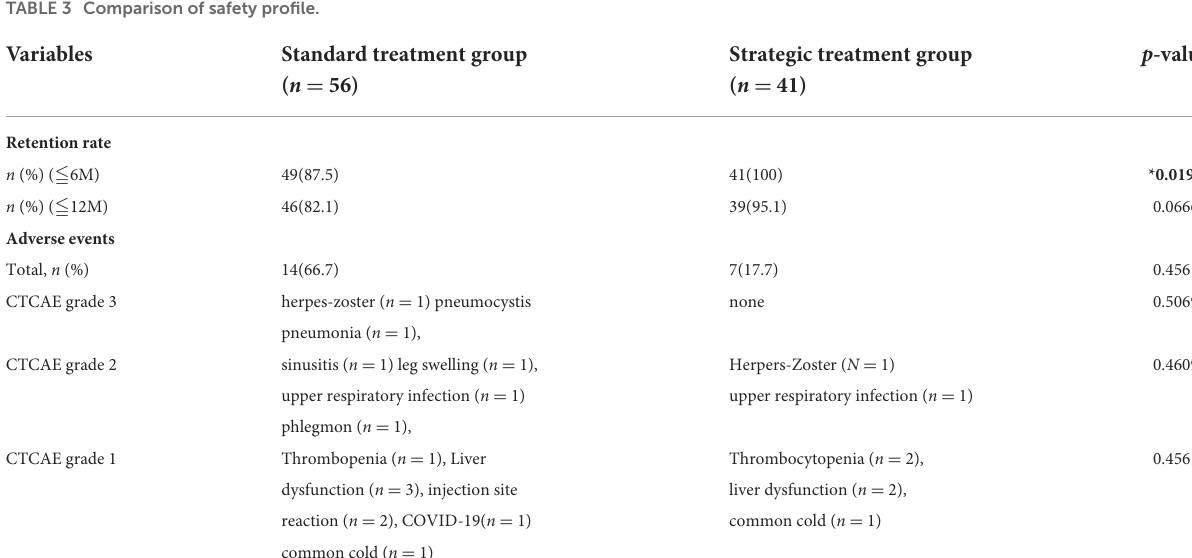
TABLE 3 Comparison of safety